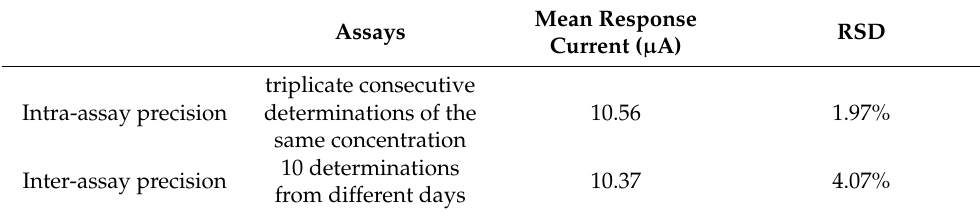
Table 1. Repeatability of cholesterol electrochemical